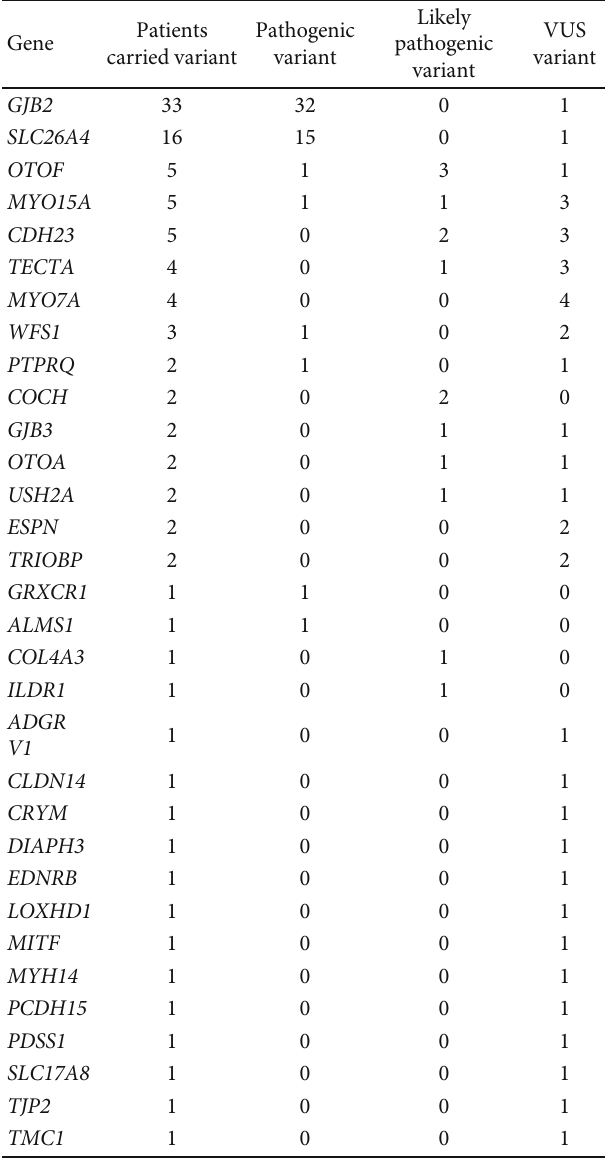
Table 2: The genetic spectrum of hereditary hearing loss patients detected by 127 gene panel testing.